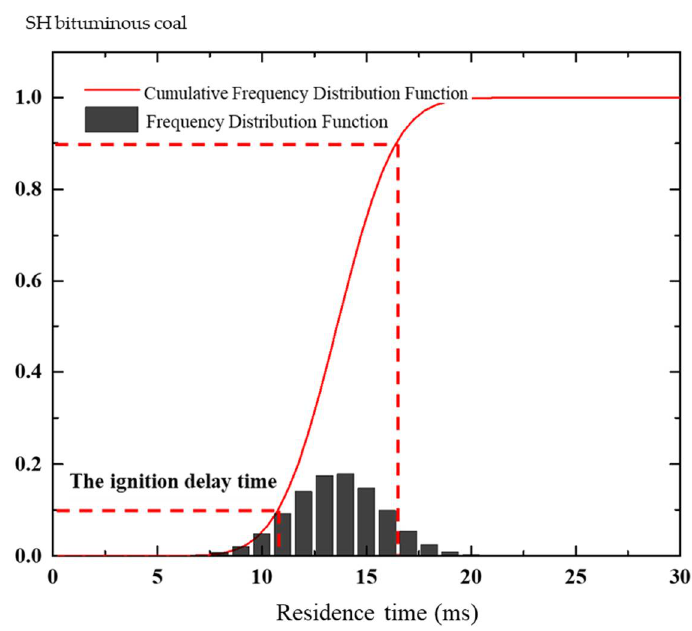
Figure 6. Method of micro frequency distribution.